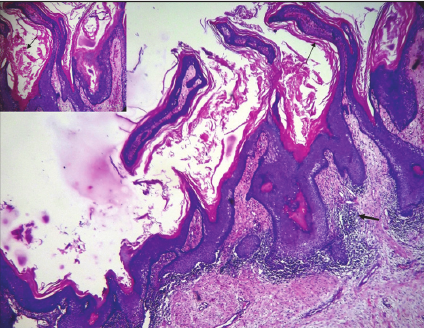
Figure 1: Cystic lesion (encircled) is seen surrounding the impacted 26, 27 and developing 28.